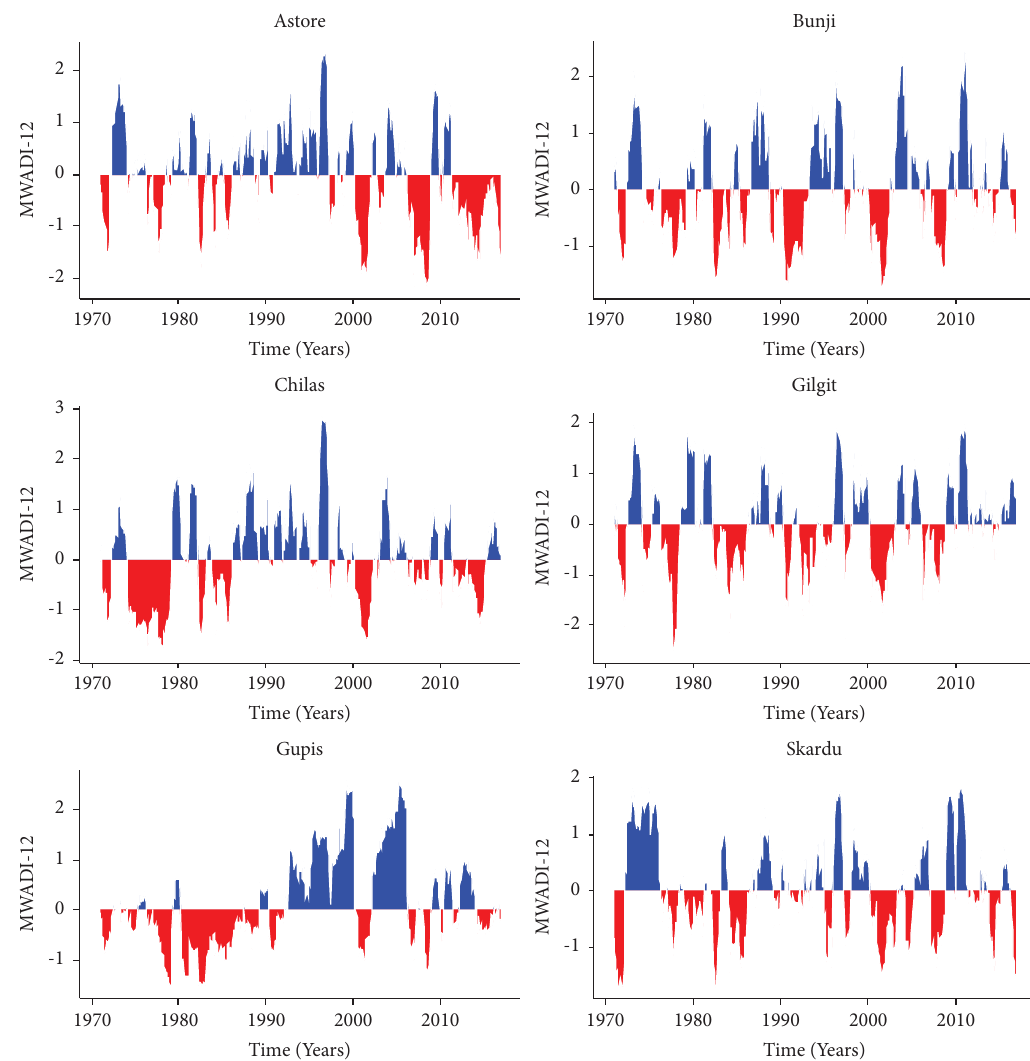
Figure 12: Temporal behavior of the MWADI at 12-month time scale at all